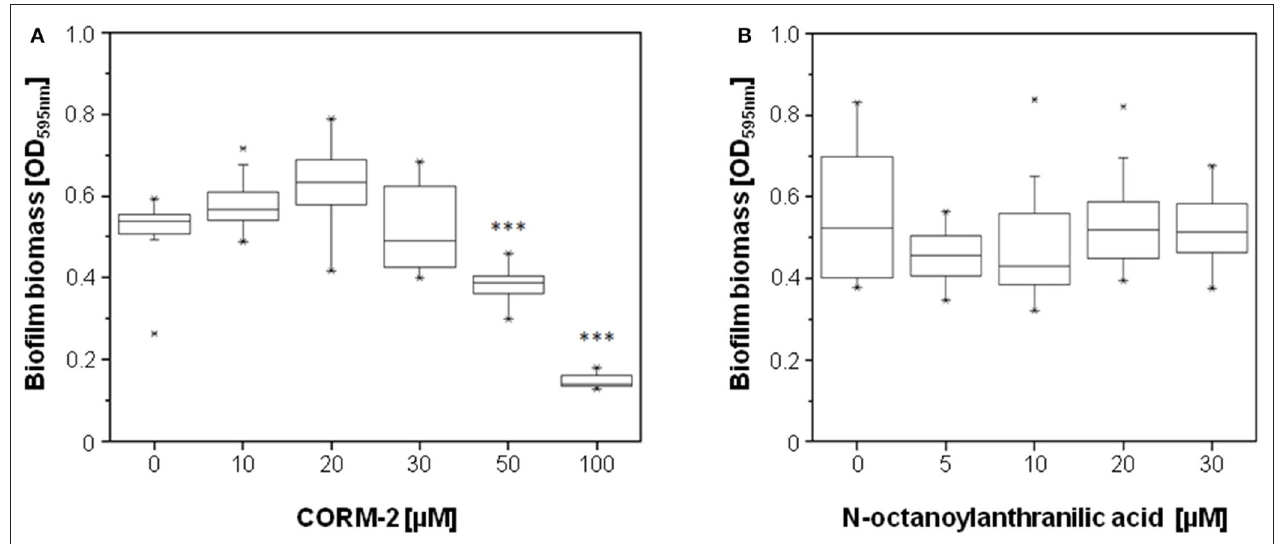
FIGURE 5 | Effect of the products of HodC-catalyzed PQS cleavage on biofilm formation of P. aeruginosa PA14 lasB ::Tn. Overnight cultures (in LB) were diluted (10 − 2 ) (A) in BM2 medium (without casamino acids), or (B) in LB, and supplemented with the either the CO-releasing molecule CORM-2 (A) , or with N -octanoylanthranilic acid (B) as indicated. After incubation for 24 h at 37 ◦ C, cells were stained with 0.1% (w/v) crystal violet and quantified by measuring OD 595nm . Experiments were done in triplicates with 6 individual repeats per measurement ( n = 18). Statistical analyses were performed with the Mann-Whitney U -test. The highest and lowest outliers are indicated by “X.” (A) *** p ≤ 0.001, in relation to biofilms of P. aeruginosa PA14 lasB ::Tn as formed in absence of